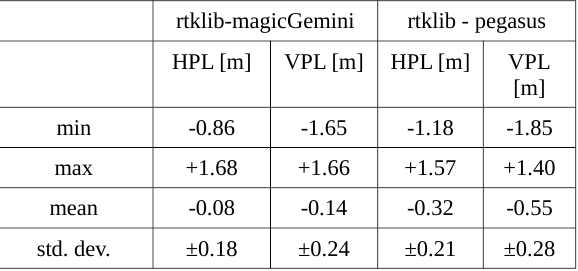
Table 2. Statistical characteristics of protection level